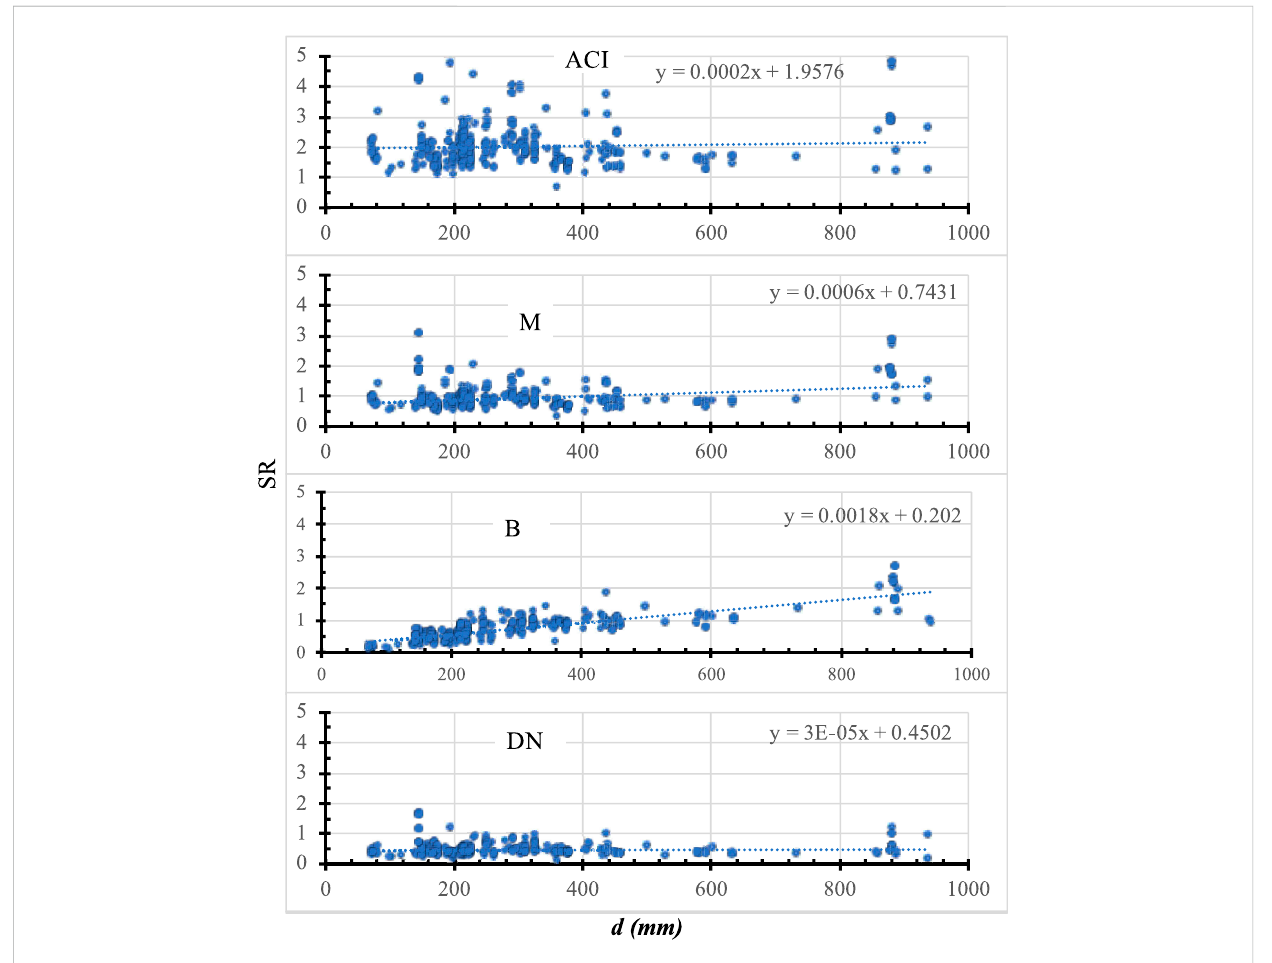
FIGURE 3 SR calculated using selected model versus